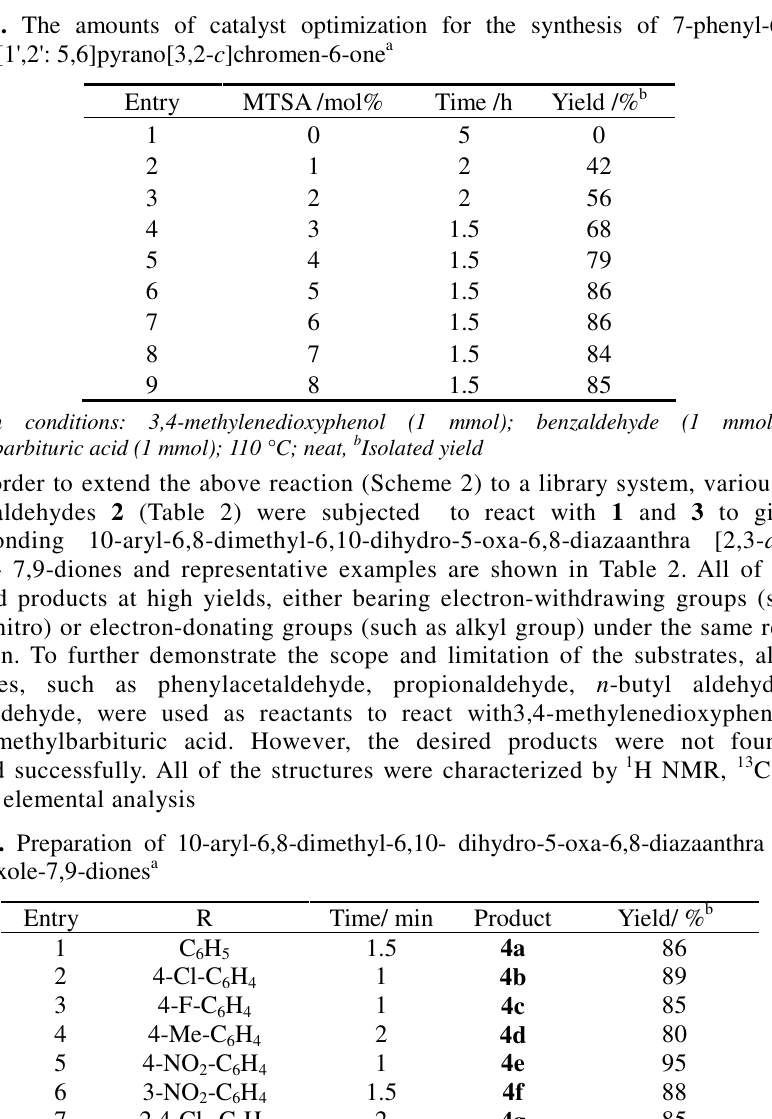
Table 2. The amounts of catalyst optimization for the synthesis of 7-phenyl-6 H ,7 H -